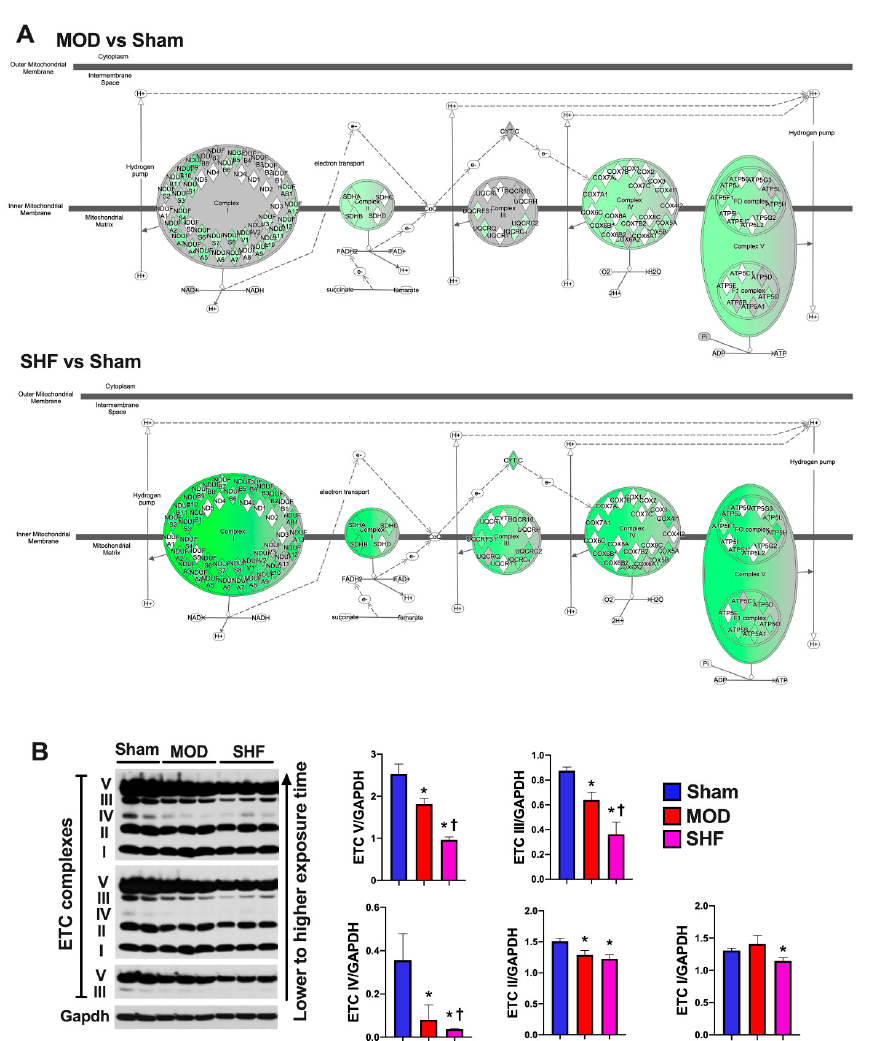
Figure 3. Oxidative phosphorylation in MOD and SHF. ( A ) Oxidative phosphorylation (OXPHOS) network of the electron transport chain (ETC) complexes I-IV transport system and ATP synthase are presented in MOD vs. Sham (upper panel) and SHF vs. Sham (lower panel). The network highlights mt OXPHOS proteins in each ETC complex that were downregulated (green) vs. Sham, were unchanged (grey) vs. Sham, or were not identified (white) in the MOD and SHF proteomic runs. The darker the green color, the higher the degree of downregulation. ( B ) Expression of the ETC complexes I-IV and ATP synthase (complex V) in MOD and SHF by immunoblotting, * p < 0.05 vs. Sham and † p < 0.05 vs. MOD.